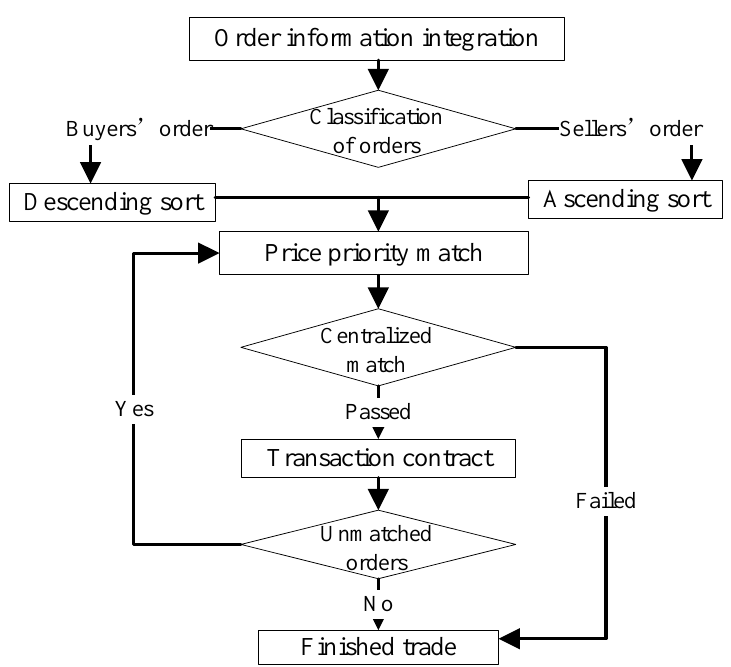
Figure 5. The process flowchart based on the cloud platform trade.